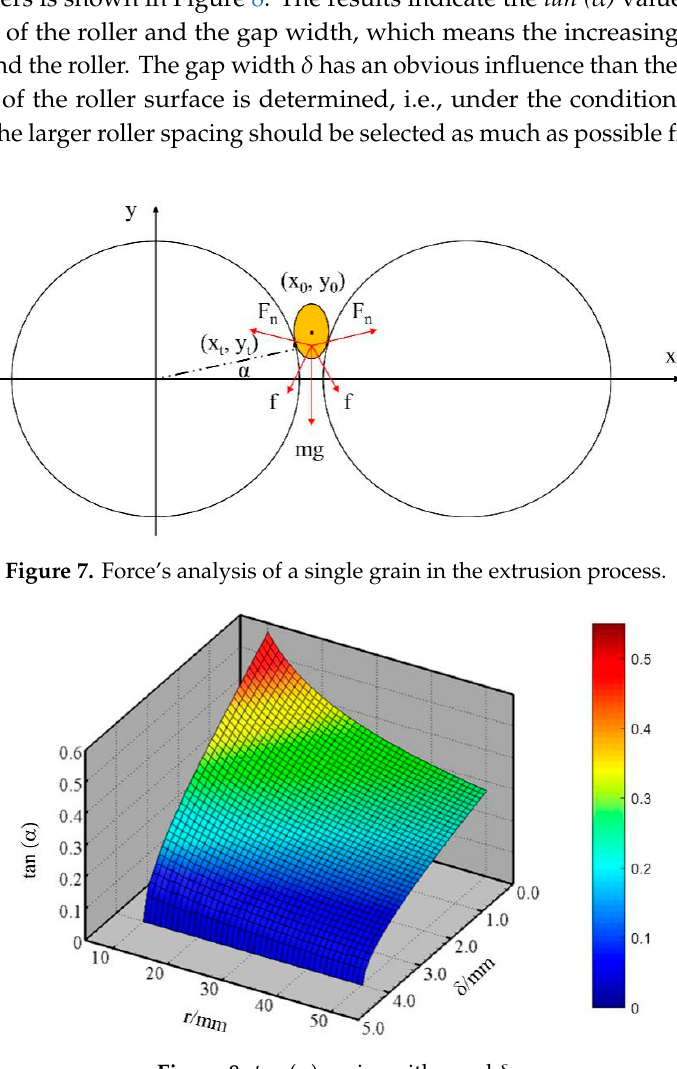
Figure 8. tan ( α ) varies with r and δ .